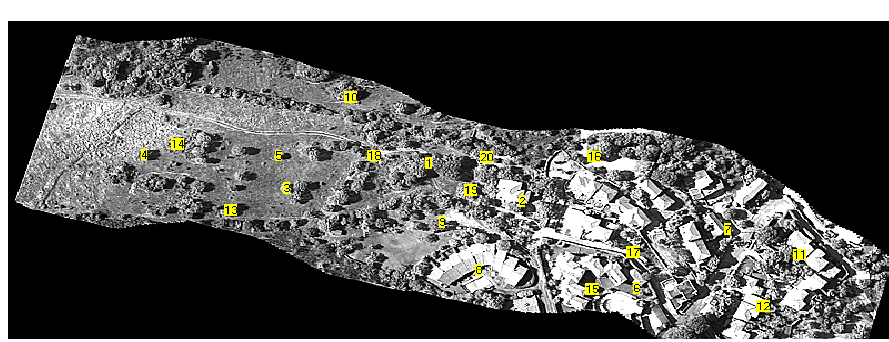
Figure 15. Georeferenced map.